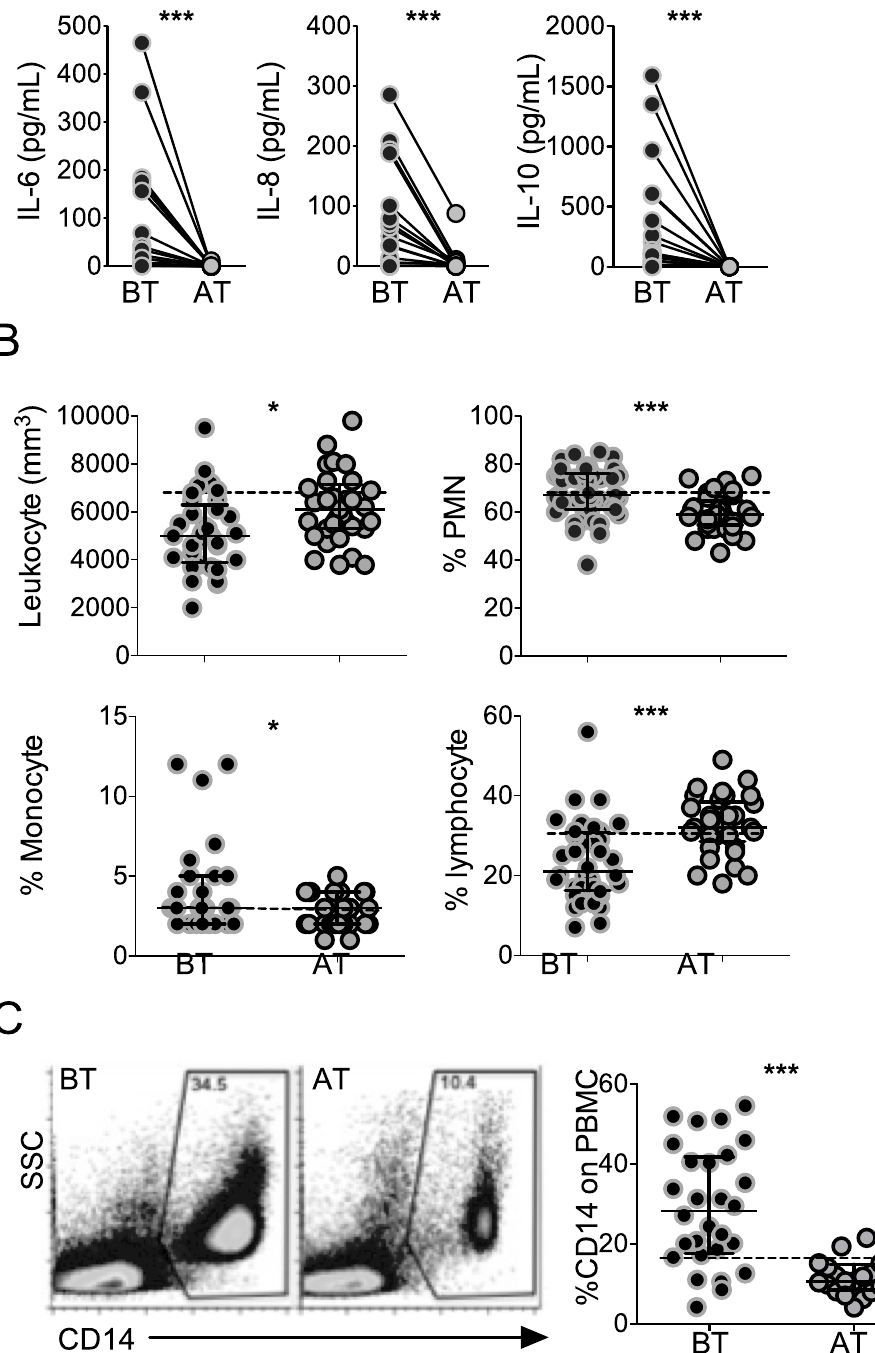
Figure 1. P. vivax -infected patients display higher levels of cytokines accompanied by increased frequencies of circulating monocytes. (A) IL-6, IL-8 and IL-10 were measured in plasma of P. vivax -infected individuals before (BT, black circles) and 30–45 days after (AT, grey circles) treatment (n=20). Levels of cytokine were measured by Cytometric Bead Array. (B) Leukocyte counts and frequencies from P. vivax -infected individuals before (BT, black circles) and after (AT, grey circles) treatment were assessed at a clinical laboratory (n=33). C) Representative density plots of CD14 + monocytes (left panel) and frequencies of CD14 + monocytes (right panel) within PBMCs from P. vivax -infected individuals (BT, n=28 and AT, n=20). Circles indicate individual patients and lines represent median values and interquartile ranges. Dotted lines represent medians of a given measurements from healthy donors. * p , 0.05, *** p , 0.01.